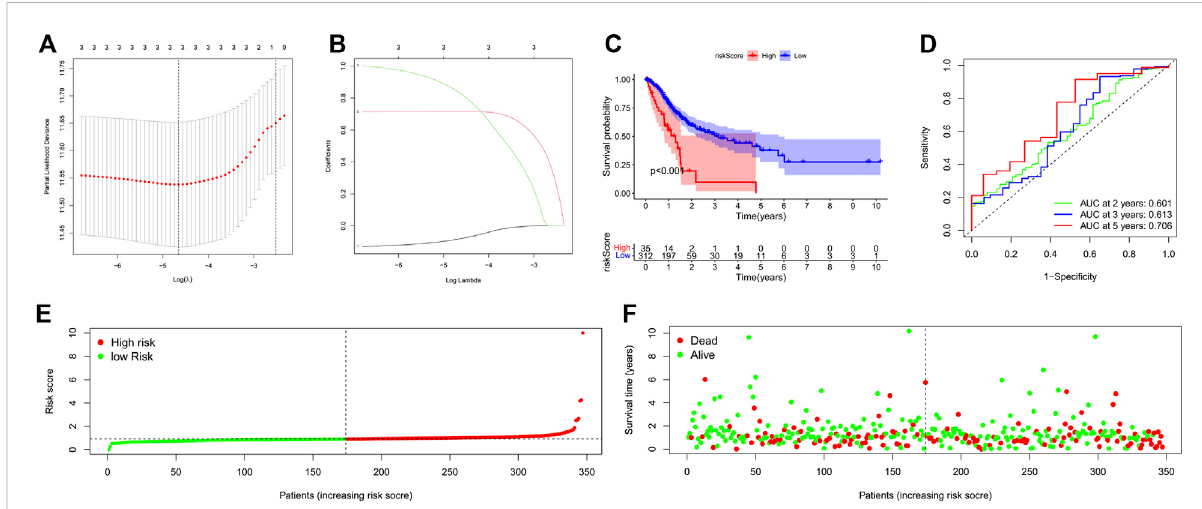
FIGURE 3 Constructionofa3-PRlncRNAs riskmodel anditspredictiveworthinessforGCsubjects onthebasis ofTCGA dataresource. (A) Logistic LASSO regressionanalisisontheoptimumlncRNAstocreatethe fi nalestimationmodel.ThetotalnumberoflncRNAsisprovidedatthetopofthe fi gure.The deviation in partial likelihood is displayed versus log lambda. Dotted vertical lines designate the optimal values. (B) Pro fi les of the core lncRNA ’ s LASSO coef fi cients. The total number of lncRNAs is indicated at the top of the fi gure. Each curve corresponds to a certain key lncRNA, and the number next to it indicates the lncRNA ’ s serial number. (C) Kaplan-Meier survival analysis of the high-GC risk and low-GC risk groups based on the riskmodelandmedianriskscoreinGCpatients. (D) Thereceiveroperatingcharacteristic(ROC)curveoftheriskmodelfortwo-year,three-year,and fi ve-year survival prediction. (E) The risk curve for each sample was on the basis of the risk score. (F) The scatterplot depicting each sample ’ s survival status. The green and red dots, respectively, signify survival and death. GC, gastric cancer; OS, overall survival. * p < 0.05; ** p < 0.01; *** p <